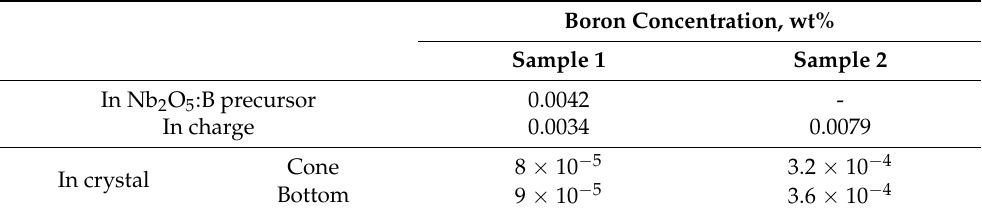
Table 1. Boron concentration in Nb 2 O 5 :B precursor, initial charge and LiNbO 3 :B crystals obtained due to different